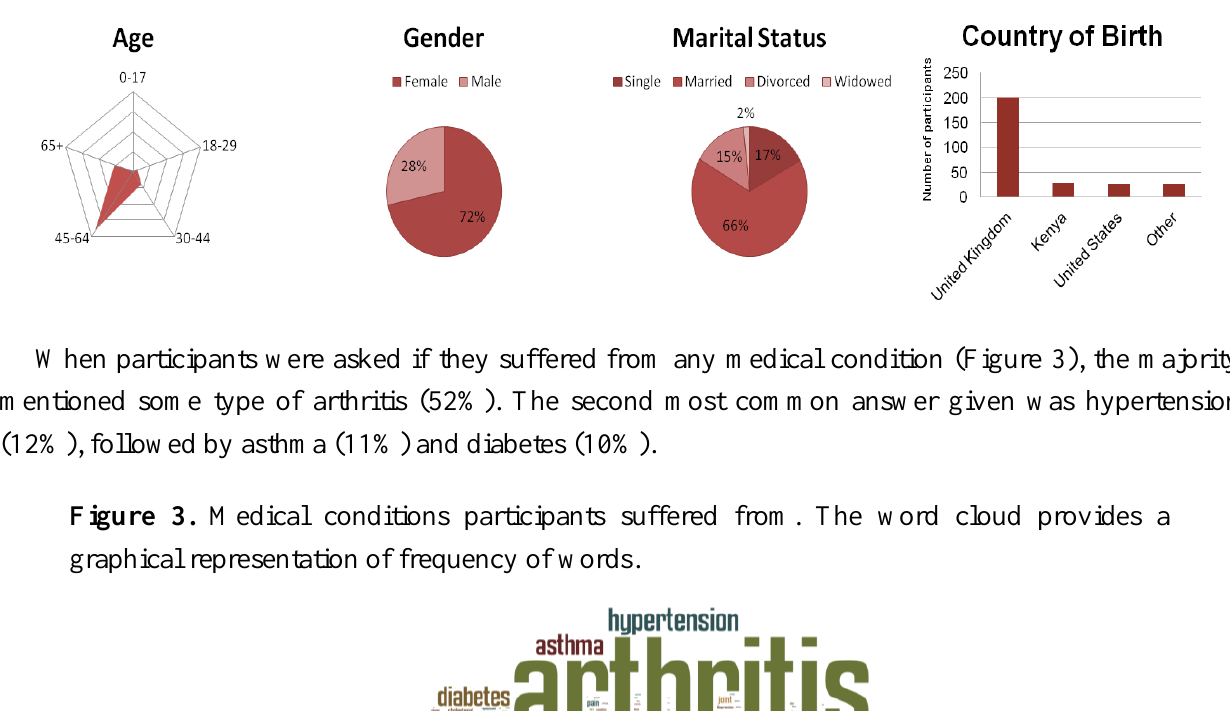
Figure 2. Demographics of the participants. Non-responders were not taken into account in these plots.